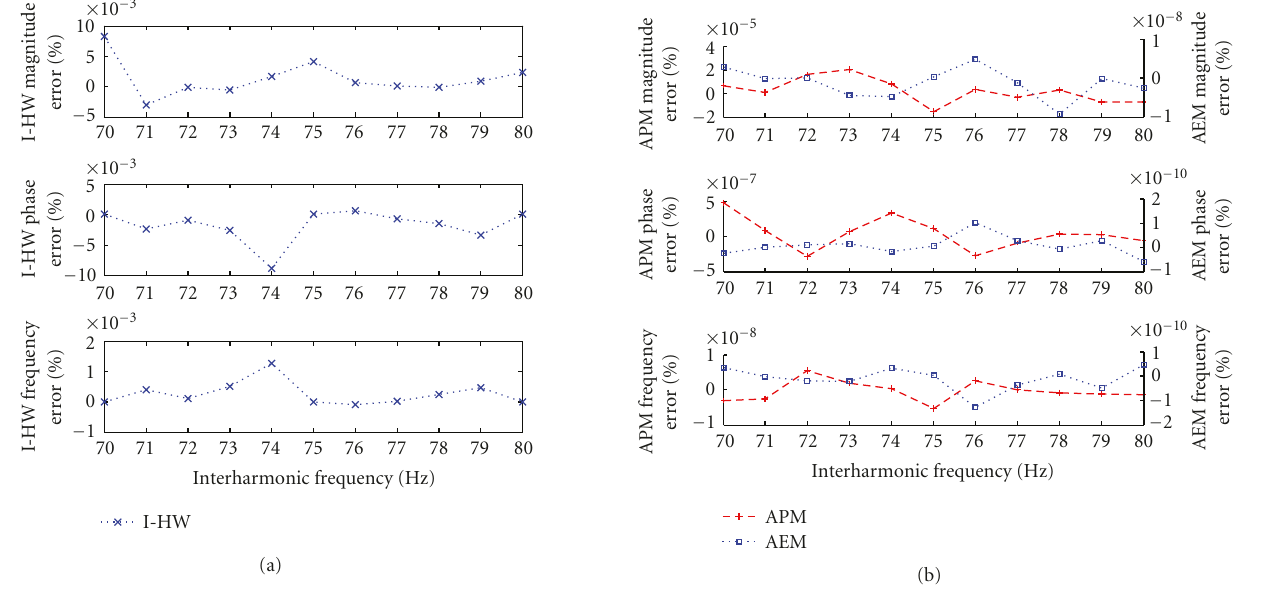
Figure 8: Case study 2: interharmonic amplitude, phase angle, and frequency error (in %) versus interharmonic frequency: (a) I-HW (dotted line x ), (b) APM (dotted line +) and AEM (dotted line (cid:3) ).